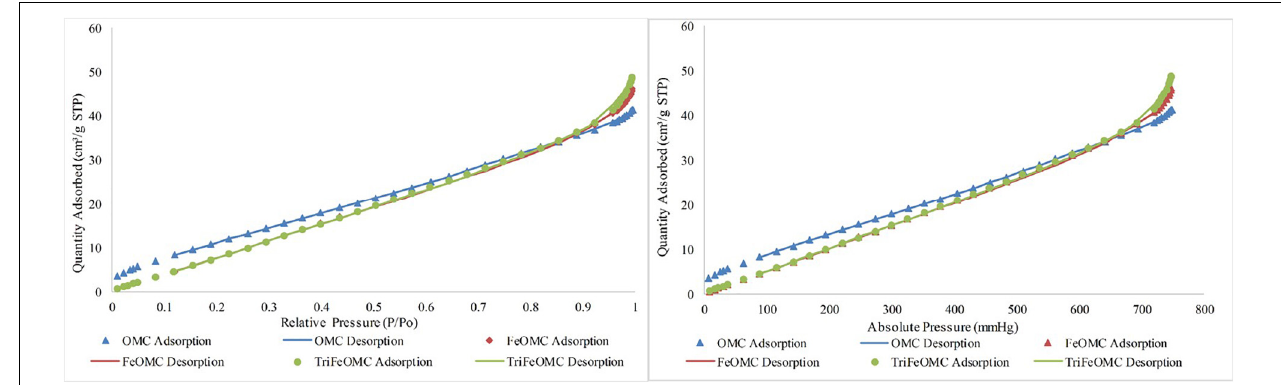
FIGURE 2 | Nitrogen adsorption/desorption Isotherm absolute and linear plots of OMC, FeOMC, and TriFeOMC.